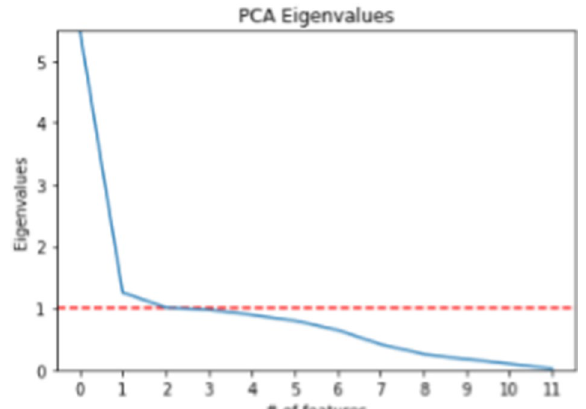
Fig. 1 An example of scree plot of PCA Eigenvalues